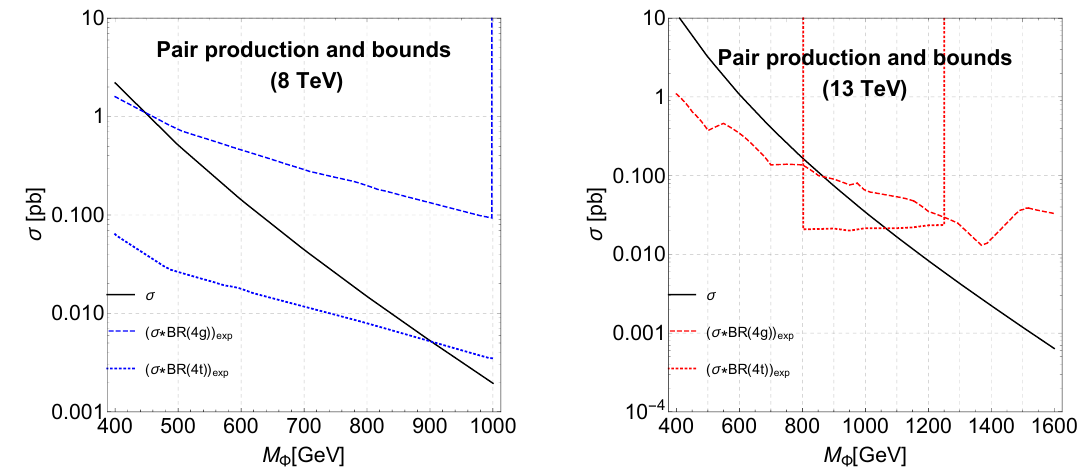
Figure 1 . Observed LHC bounds on cross sections from 4-top searches and di-jet-pair searches at run I (left) and run II (right). For reference, the black lines show the total QCD pair production cross section at the respective center-of-mass